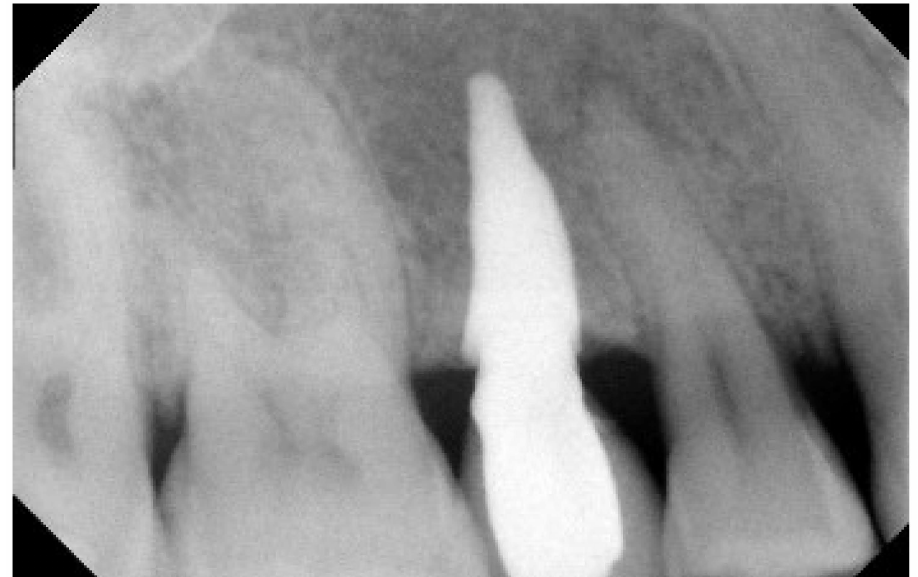
Figure 4. Two-year Rx follow-up. Rx check, 2 years after